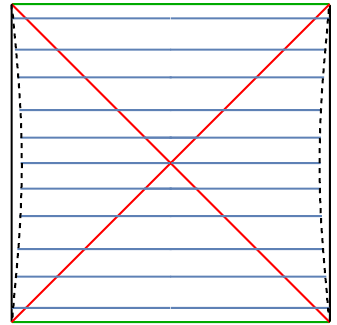
Figure 4. Penrose diagram for the AdS 2 black hole and the geodesics in blue connecting equal times at the two boundaries. R b = 10 is the black dashed